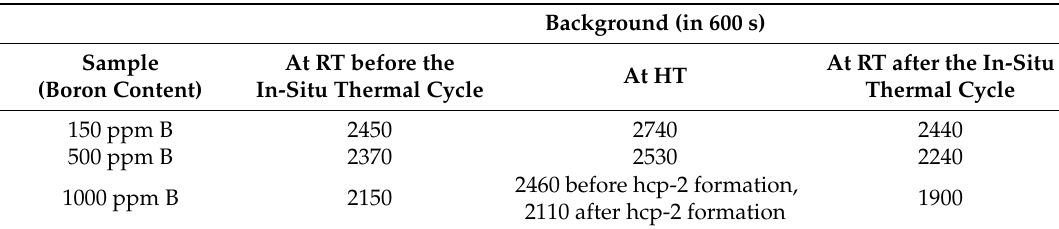
Table 3. The background intensity at 2 θ = 55 ◦ for three boron containing samples. The estimated error is ± 50 for all the values in the